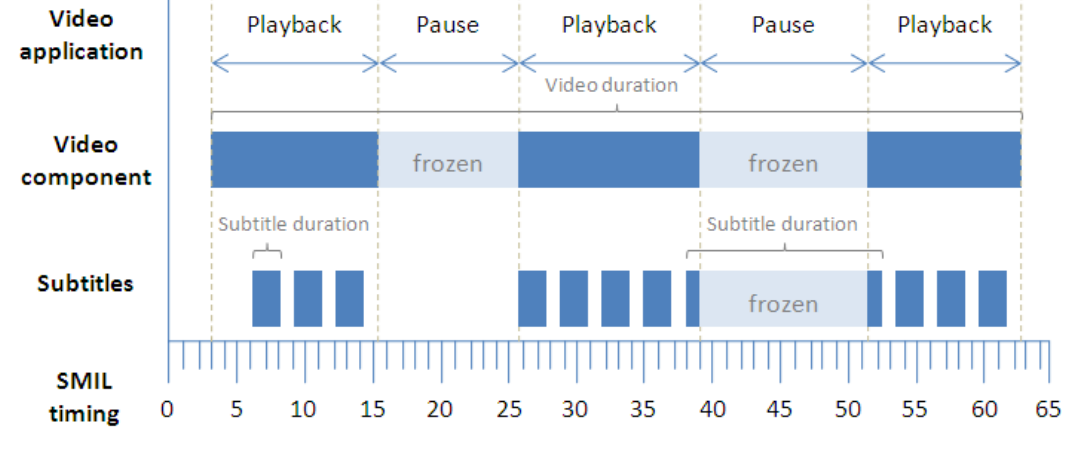
Figure 3. JS code of the video events added to the SMIL container for synchronizing subtitles.